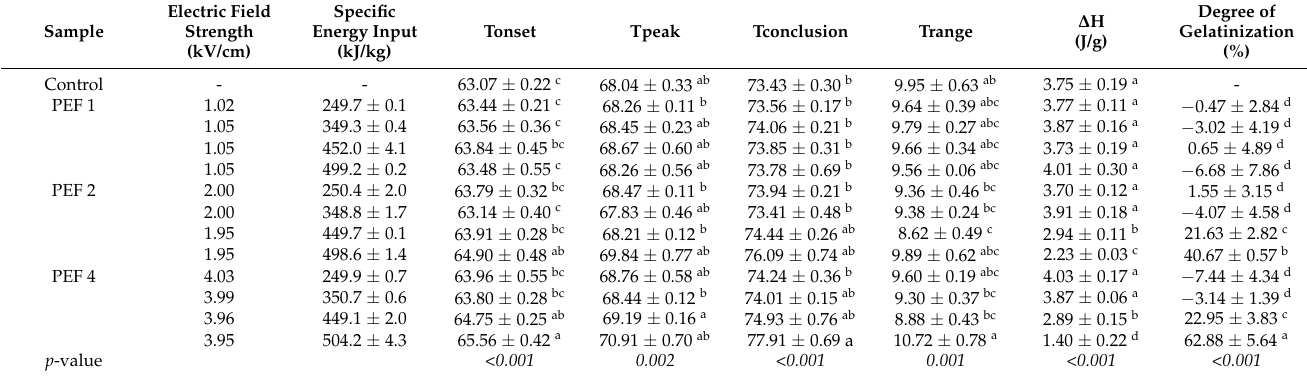
Table 4. Gelatinization transition properties of PEF-treated cassava flours determined through